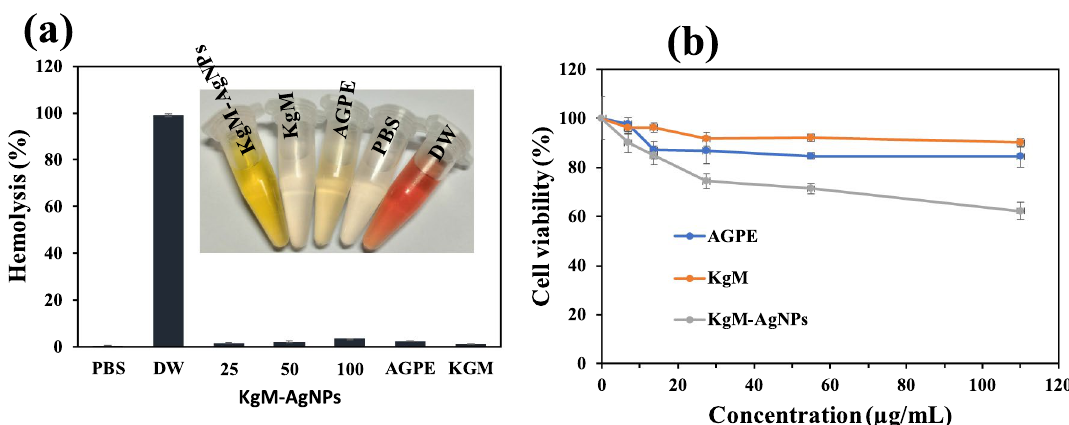
Figure 6. Effect of KgM-AgNPs, AGPE and KgM on ( a ) rat erythrocyte hemolysis and ( b ) viability of mouse